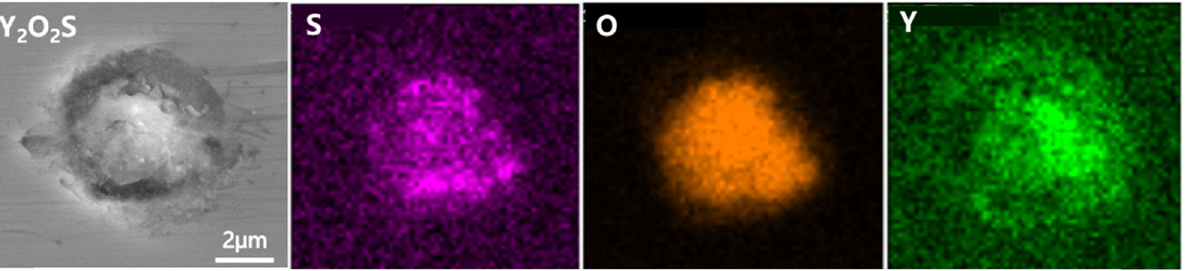
Figure 5: Elemental distribution of Y 2 O 2 S in hot - rolled Y - bearing steel.